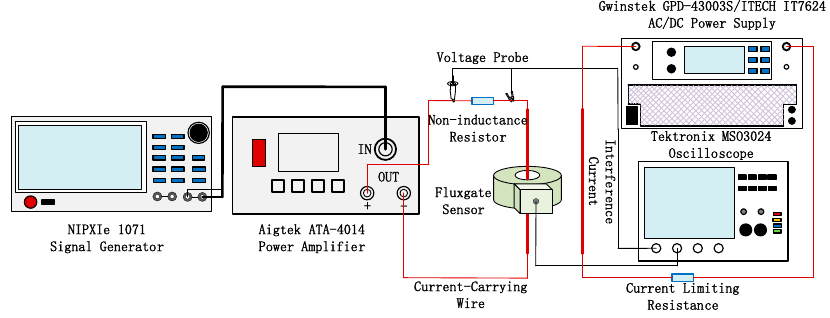
Figure 17. Anti-interference performance test platform. Table 2. Comparison of Shielding Effect under Different